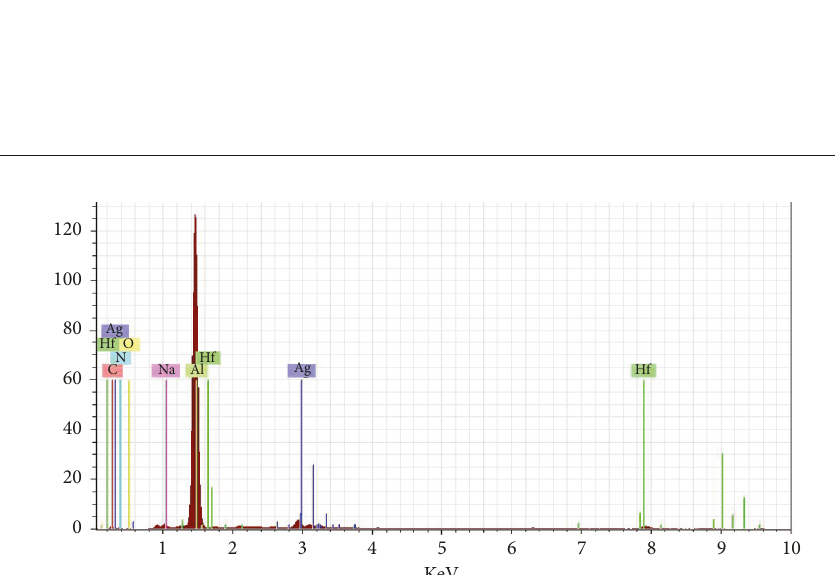
Table 2: Particle size of green-synthesized AgNPs by Malva parviflora leaves extract using SEM. Number of lines